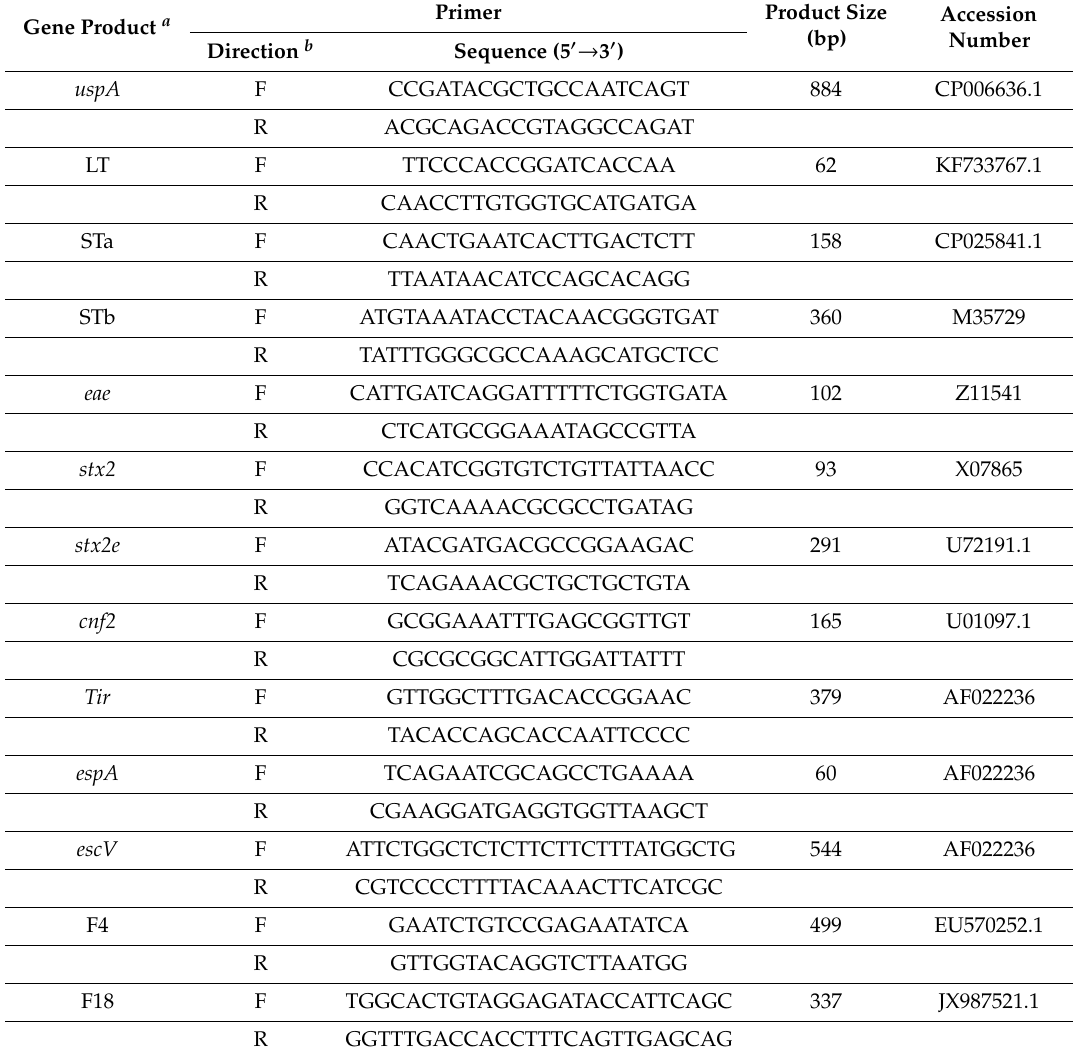
Table 2. Sequences of oligonucleotide primers used for PCR, length of the respective PCR product, and gene accession